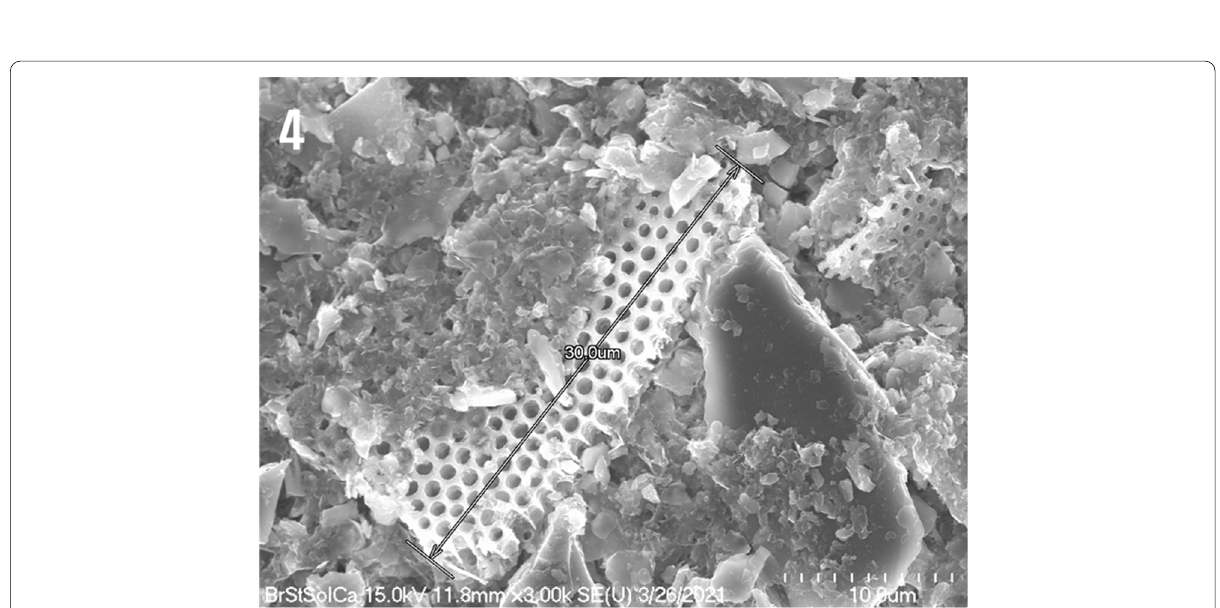
Fig. 4 Scanning electron micrograph of the complex hierarchical and well-maintained inherent porous structure of a diatom